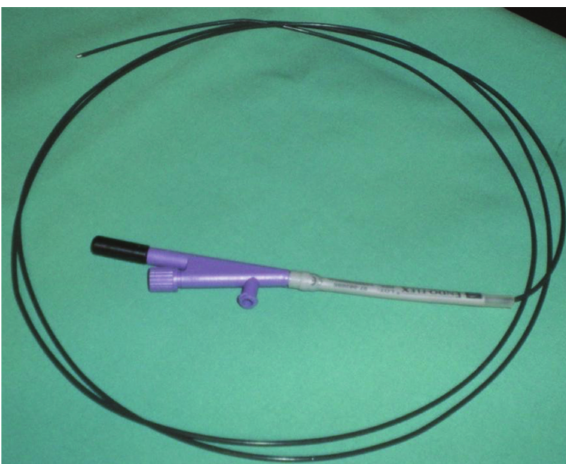
Figure 1: 6F cystostome (Endoflex company).